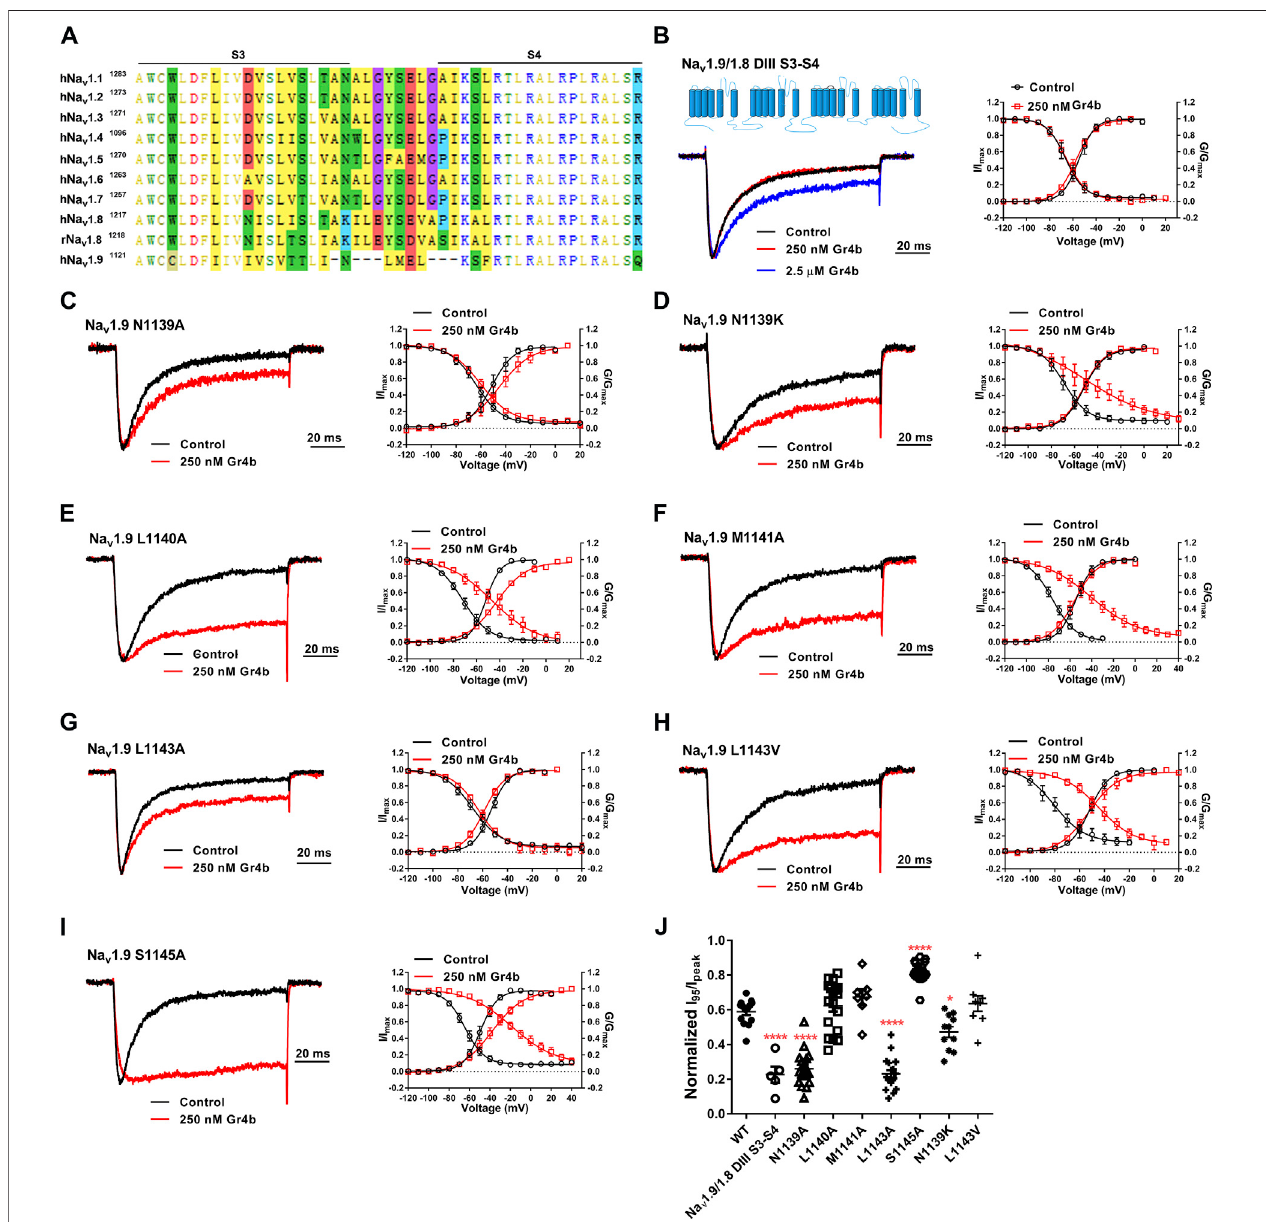
FIGURE 6 | DIII S3-S4 of Na v 1.9 is involved in interacting with Gr4b. (A) Sequence alignments corresponding to Na v subtype domains III (DIII) S3-S4. (B) Representative normalized current traces, voltage-dependent steady-state activation and voltage-dependent steady-state inactivation show that the chimera channels (constructedasthecartoonillustrated)Na v 1.9/1.8 DIIIS3-S4,intheabsence(black), presence of250 nMGr4b(red) or 2.5 μ MGr4b(blue). (C – I) Representative traces, voltage-dependent steady-state activation and voltage-dependent steady-state inactivation show that the single point mutations of Na v 1.9, in the absence (black) andpresenceof250 nMGr4b(red). (J) EffectsofGr4bonWTandmutantNa v 1.9channels.Dotplotsdisplaytheeffectof250 nMGr4bonthepersistentcurrent(n (cid:2) 17 for N1139A, n (cid:2) 11 for N1139K, n (cid:2) 18 for L1140A and L1143A, n (cid:2) 7 for M1141A, n (cid:2) 9 for L1143V, n (cid:2) 20 for S1145A and n (cid:2) 5 for Na v 1.9/1.8 DIII S3-S4). One-way ANOVA with Dunnett ’ s Multiple Comparison Test and compared with WT, * p < 0.05, **** p < 0.0001.